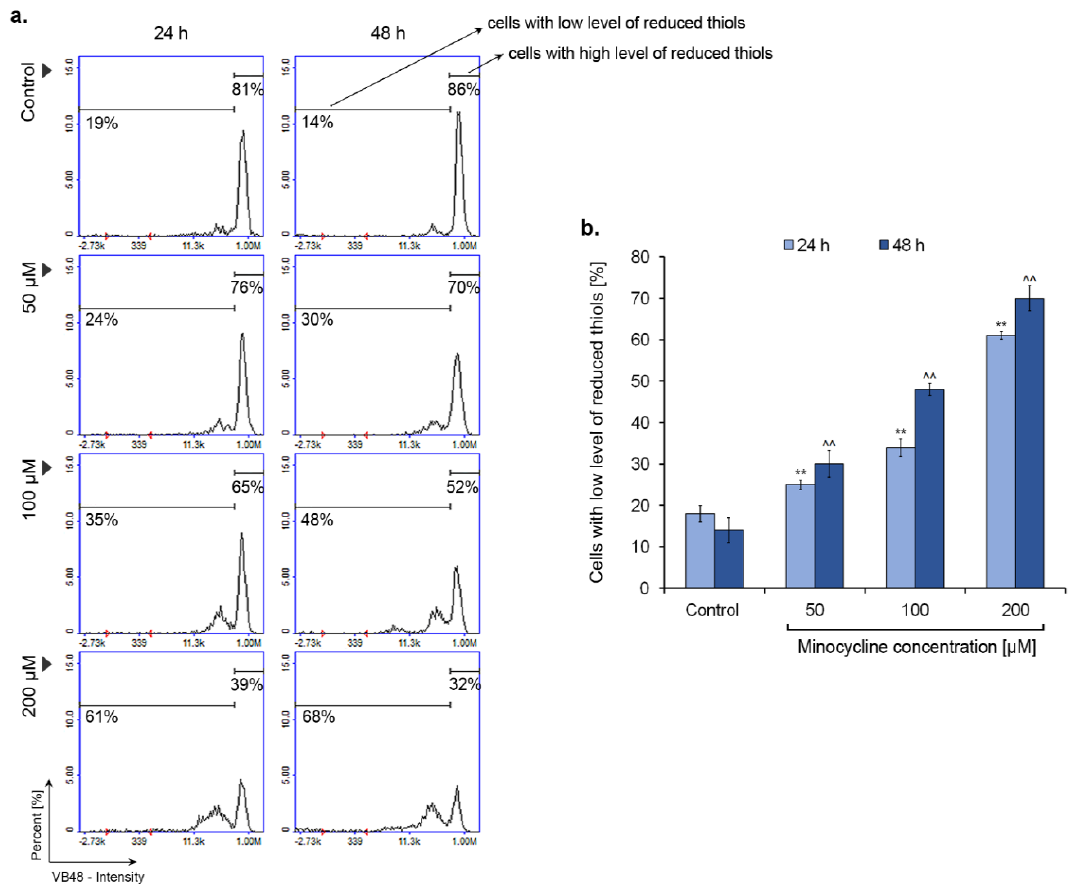
Figure 7. Minocycline decreases the intracellular level of reduced thiols in human melanoma cells after 24 h and 48 h incubation. Individual markers respond to cells with decreased level of reduced thiols and cells with high level of reduced thiols ( a ). Mean values of the percentage of cells with low level of reduced thiols are presented in the bar graph ( b ). ** p < 0.005 vs. control 24 h; ˆˆ p < 0.005 vs. control 48 h.